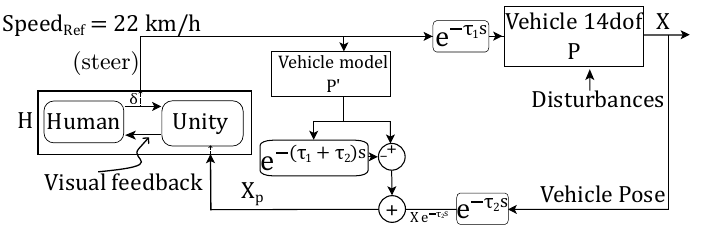
Figure 6. Smith-predictor